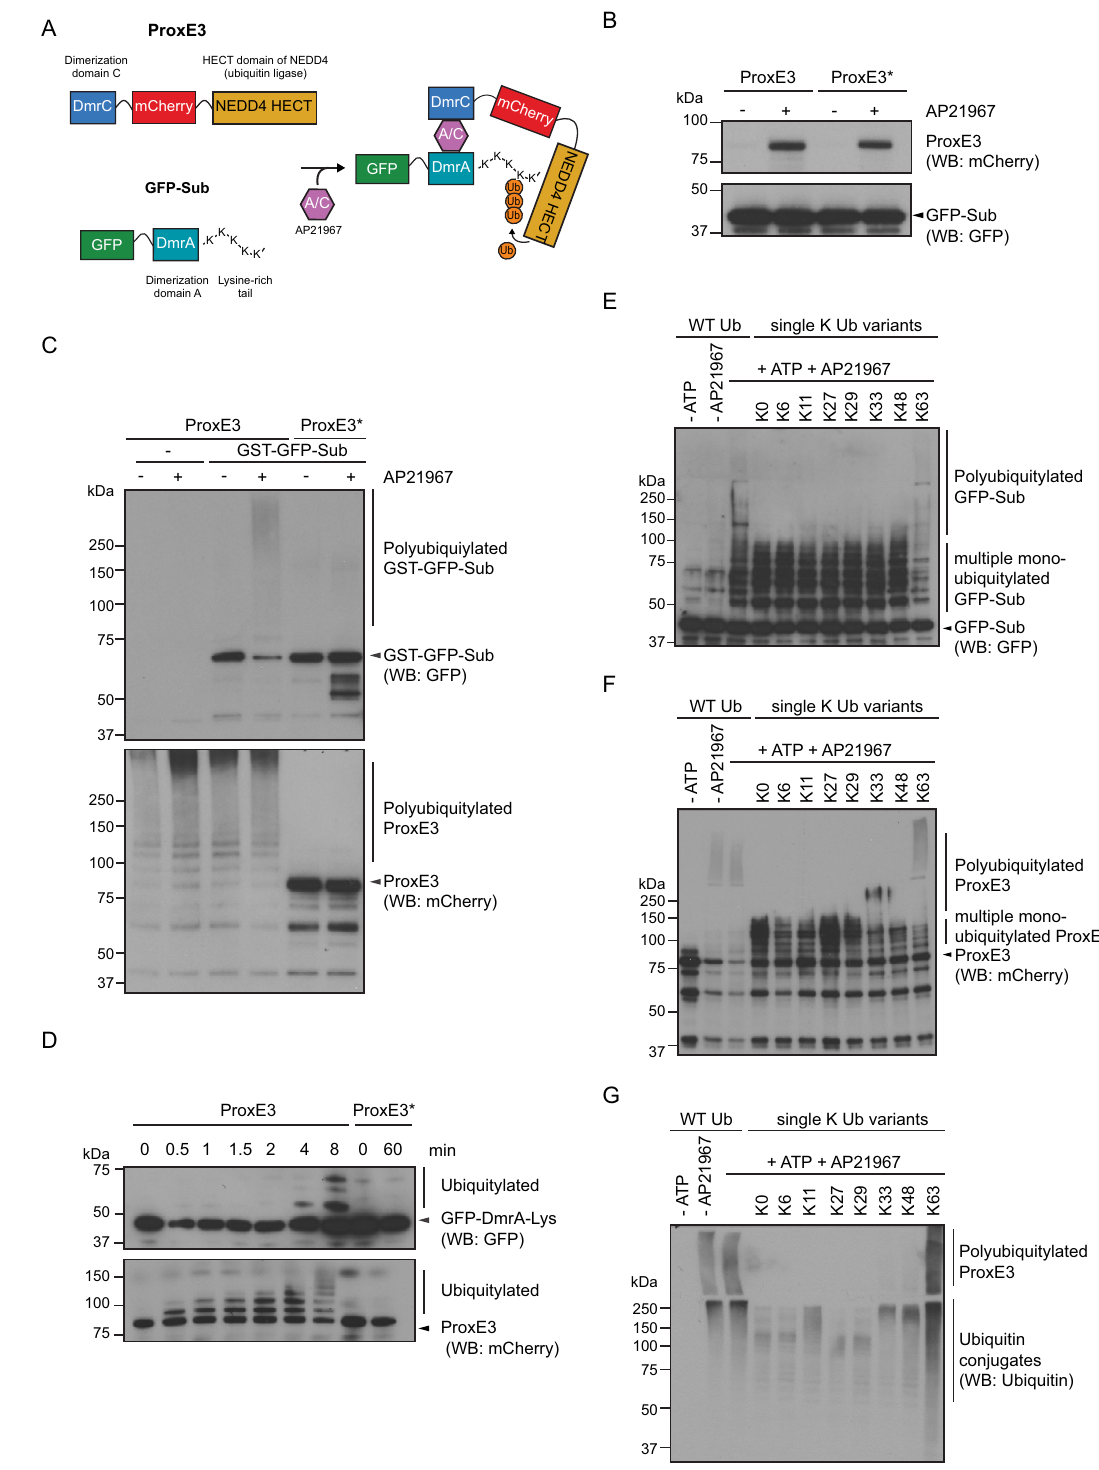
Figure 1. ProxE3: an engineered ubiquitin ligase for inducible K63-linked polyubiquitylation. ( A ) Schematic illustration of the ProxE3 ligase and its substrate GFP-Sub. Dimerization of the DmrC domain in ProxE3 and the DmrA domain in GFP-Sub is induced by the heterodimerizer AP21967 and results in specific K63-linked ubiquitylation of GFP-Sub. ( B ) In vitro heterodimerization of GFP-Sub and mCherry-ProxE3. Recombinant GFP-Sub was immobilized on GFP-Trap magnetic beads prior to addition of mCherry-ProxE3 in the presence or absence of AP21967. ( C ) One-hour in vitro ubiquitylation reaction using mCherry-ProxE3 or the catalytically inactive mCherry-ProxE3* in the presence or absence of AP21967, with or without immobilized GST-tagged GFP-Sub. ( D ) In vitro ubiquitylation kinetics of GFP-Sub by mCherry-ProxE3 or the catalytically inactive mCherry-ProxE3* and auto- ubiquitylation of the ligases. ( E – G ) One-hour in vitro ubiquitylation reaction of GFP-Sub by mCherry-ProxE3 with WT ubiquitin (WT Ub), a lysine-less ubiquitin mutant(UbK0) or single lysine ubiquitin mutants. Arrows are pointing towards the unmodified protein of interest (either GFP-Sub or ProxE3). ( E ) GFP detection, Western blot. ( F ) mCherry detection, Western blot. ( G ) Ubiquitin detection, Western